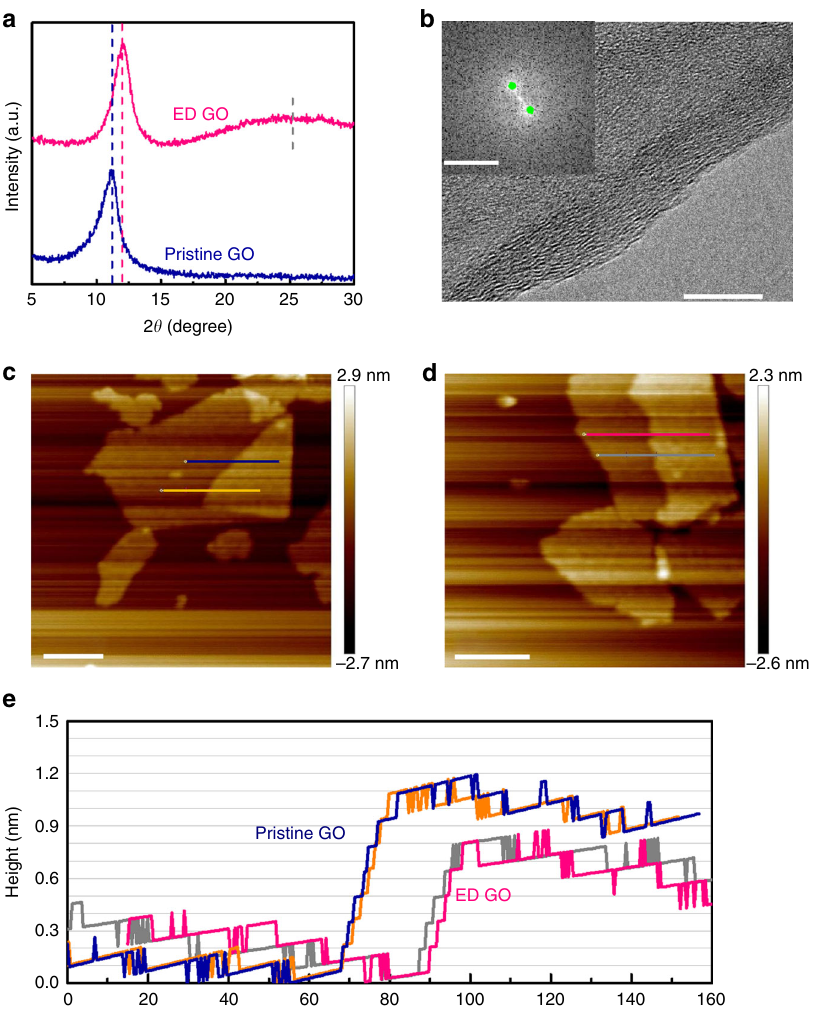
Fig. 3 Structure analysis of ED-GO layers. a X-ray diffraction (XRD) patterns of pristine and ED-GO, b HRTEM cross-section image of ED-GO fragment (inset: fast Fourier transform of TEM image), AFM measurements of c pristine GO and d ED-GO bilayers and e layer height pro fi les of the GO bilayers (offsets made for clarity), scale bars b 10 nm, inset b 5 nm − 1 and c , d 100